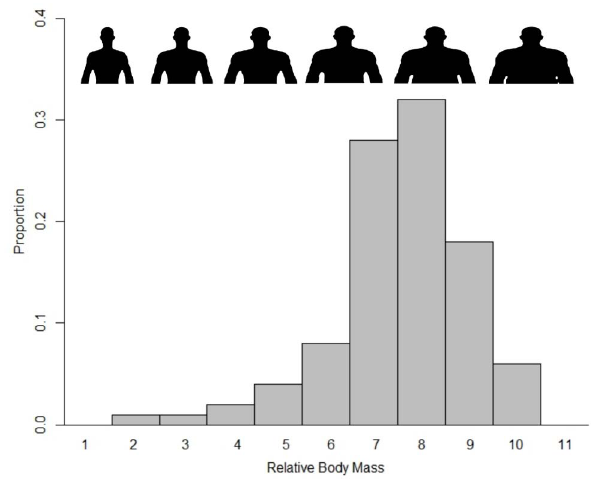
Figure 2. Distribution of relative body mass (RBM) of hunters from British Columbia and Alberta, Canada, sampled from social media data. Visual anchors left to right at 1, 3, 5, 7, 9 and 11. To protect the privacy of hunters in online photographs, we used cartoon images of men with appropriate morphology to display variation in